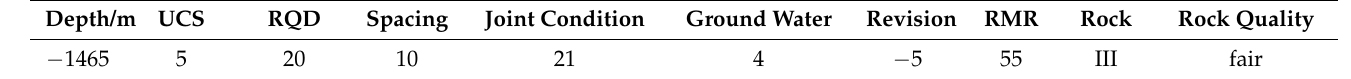
Table 3. Classification results of rock mass quality based on RMR.